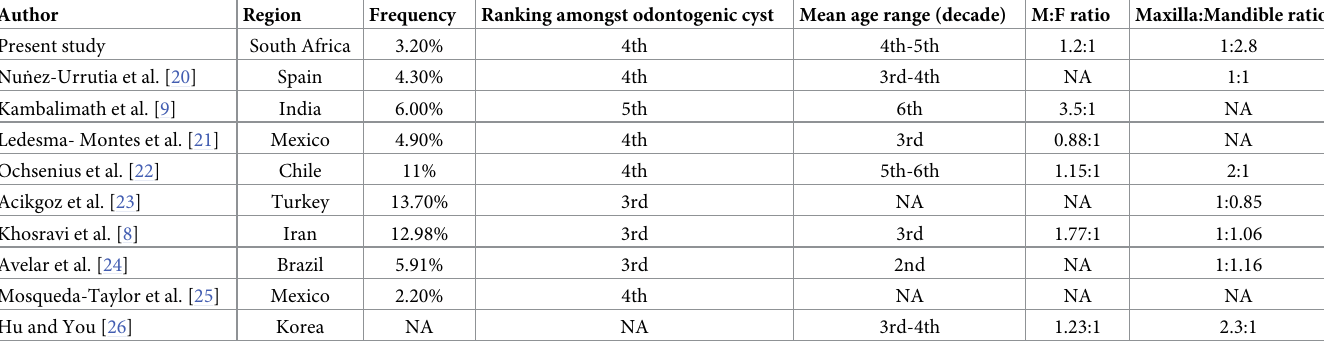
Table 2. Frequency and demographics of residual cysts in the jaws in the